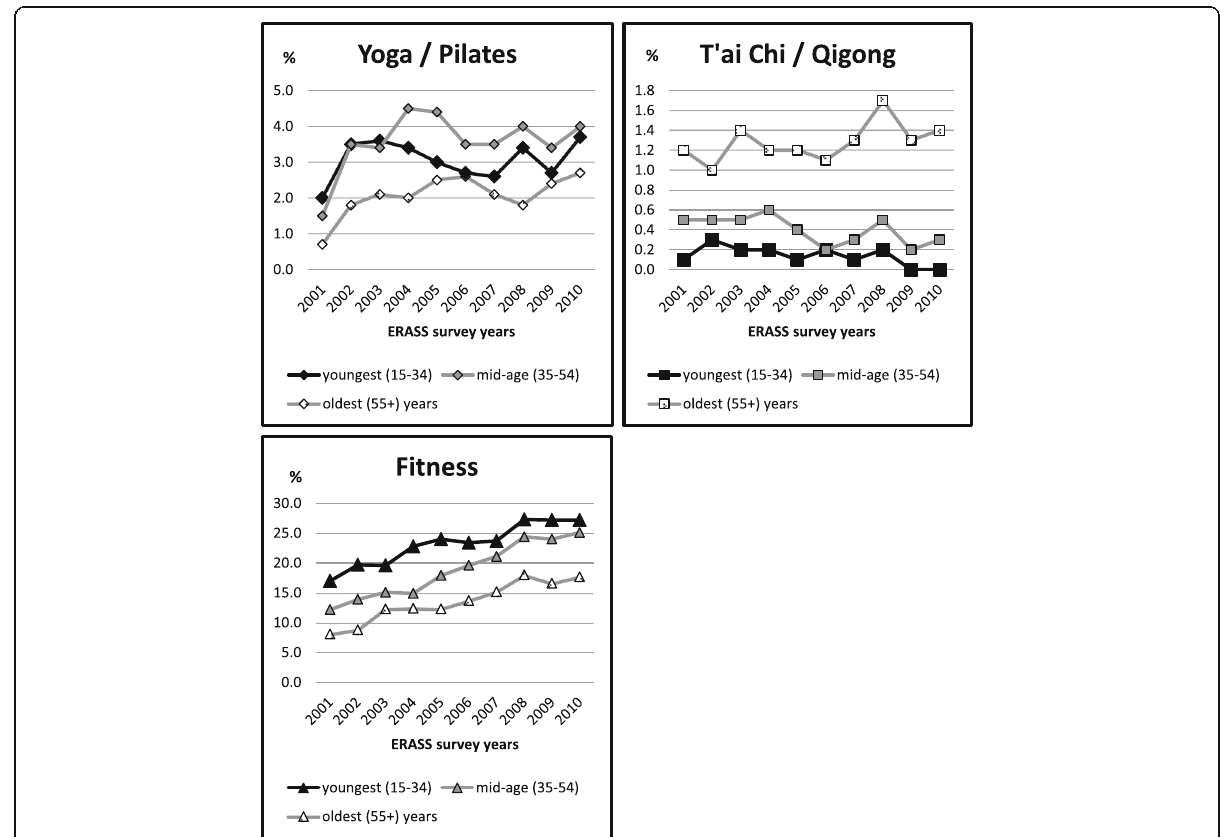
Fig. 2 Ten-year participation trends in yoga/Pilates, t ’ ai chi/qigong and fitness, showing prevalence by age